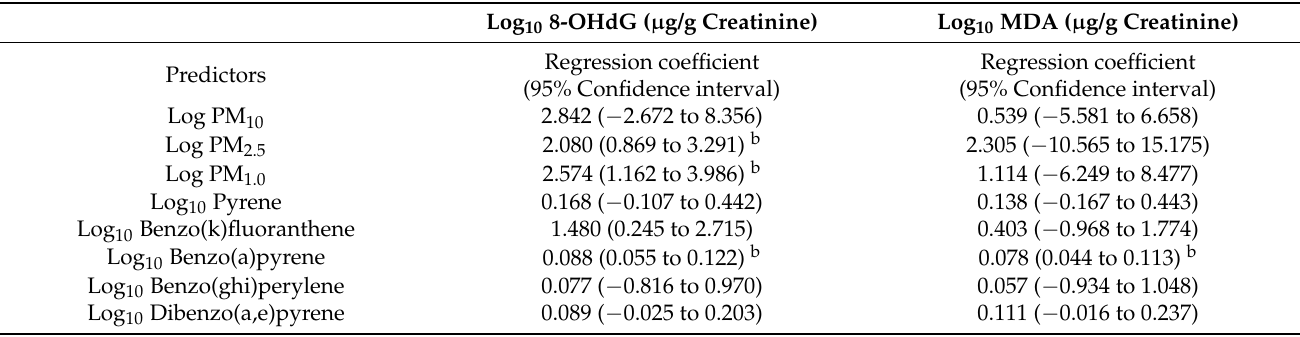
Table 4. Predictors of cross-shift changes in urinary 8-OHdG and MDA levels in 54 cooks using linear mixed-effect regression models a